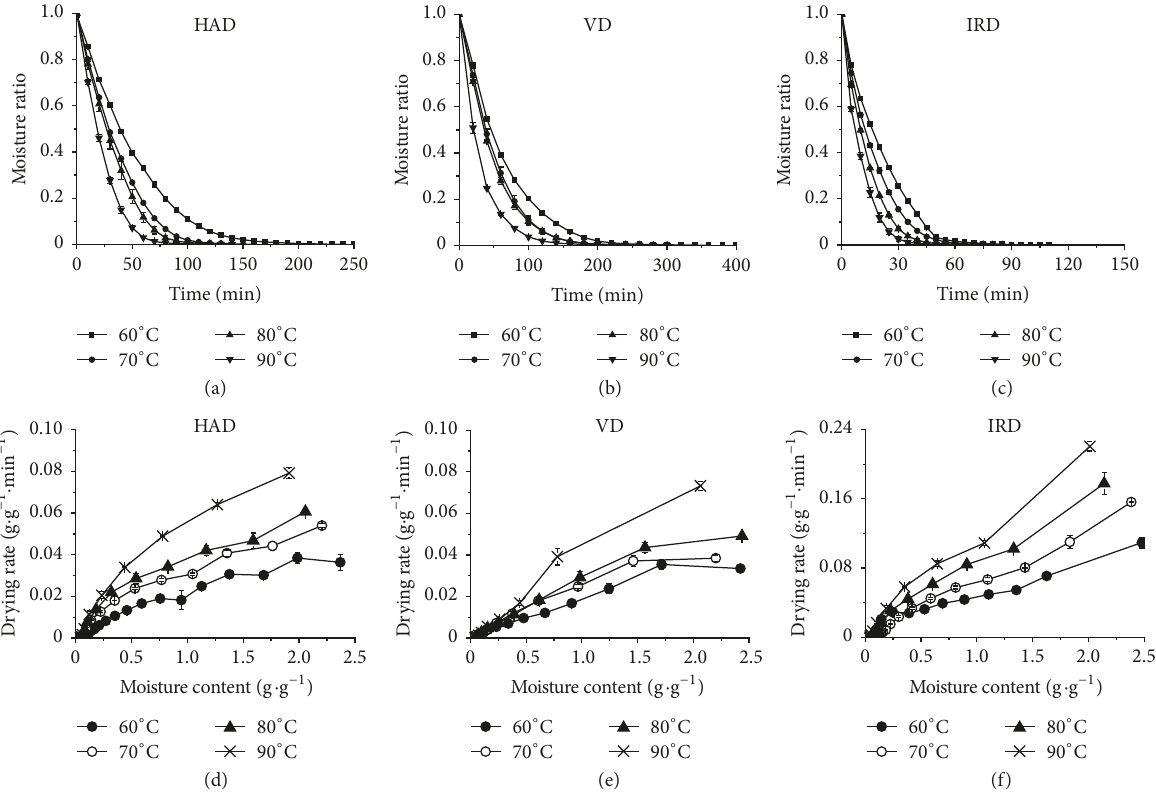
Figure 2: Drying curves and drying rate curves of tangerine peels dried by hot-air drying (a, d), vacuum drying (b, e), and medium- and short-wave infrared radiation drying (c,